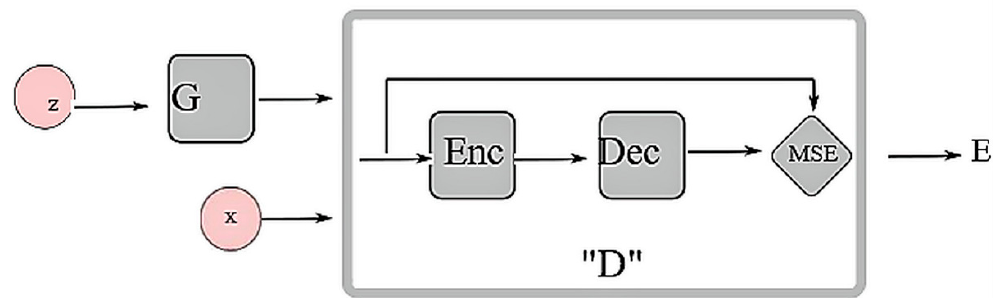
Figure 7. Energy-based generative adversarial network with Z as the noise space, X as the original image, and E as the energy assignment to the given generated variable.